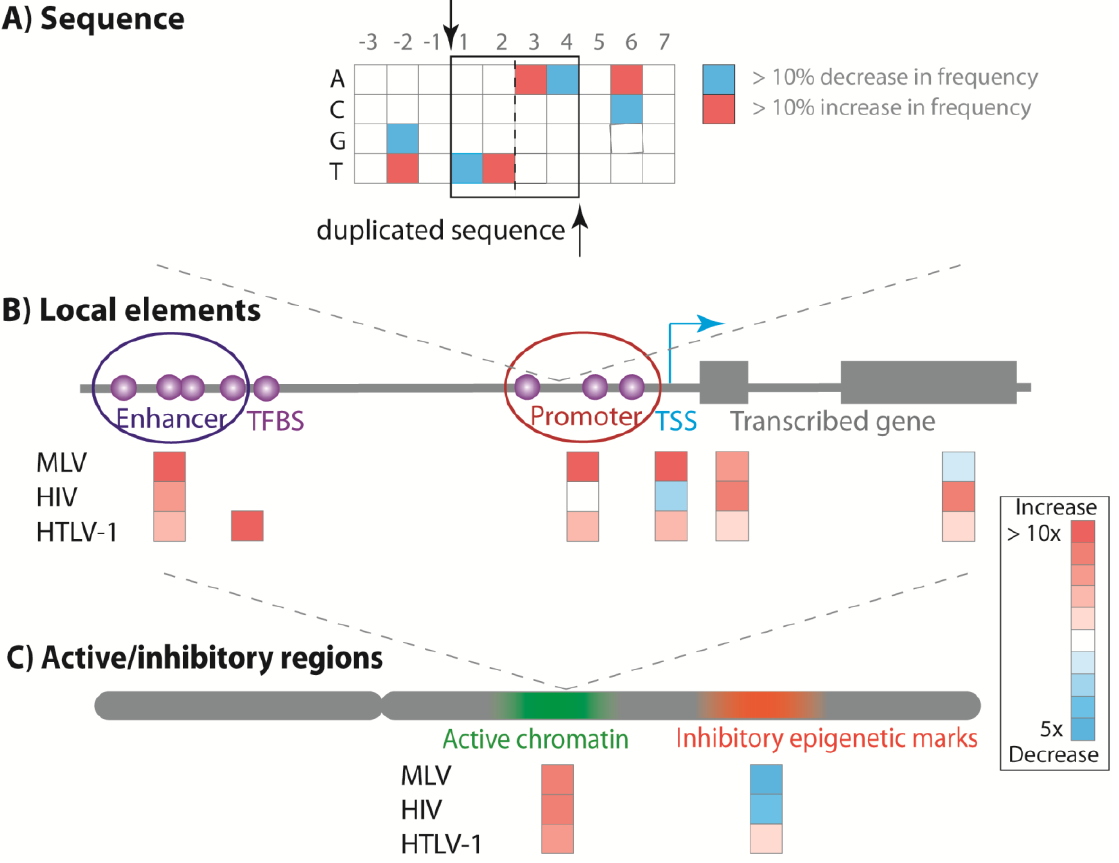
Figure 1. Genomic features associated with retroviral integration sites. The site of